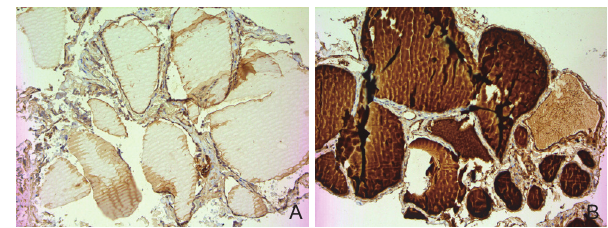
Figure 4 Expressions of HSP70 in transitional zones of thyroid adenoma before and shortly after thermal ablation (×200). (A) weak expressions of HSP70 in the transitional zone before ablation; (B) strong expressions of HSP70 in the transitional zone shortly after ablation.